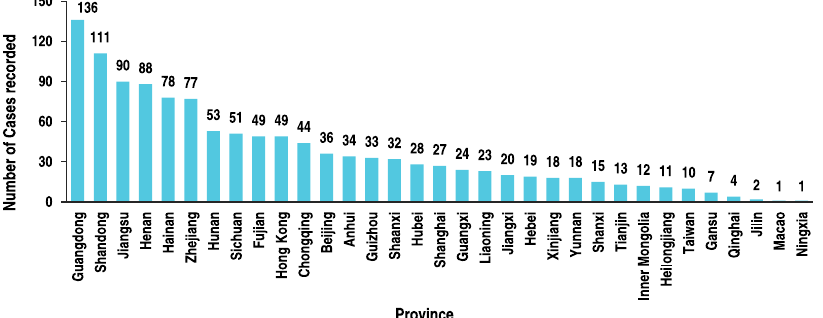
Fig. 1 Province distribution of meat FF cases reported in domestic news and supervision & sampling inspection noti fi cations. The columns indicate the total number of incidents in each province checked or reported as substandard based on the adulterants.